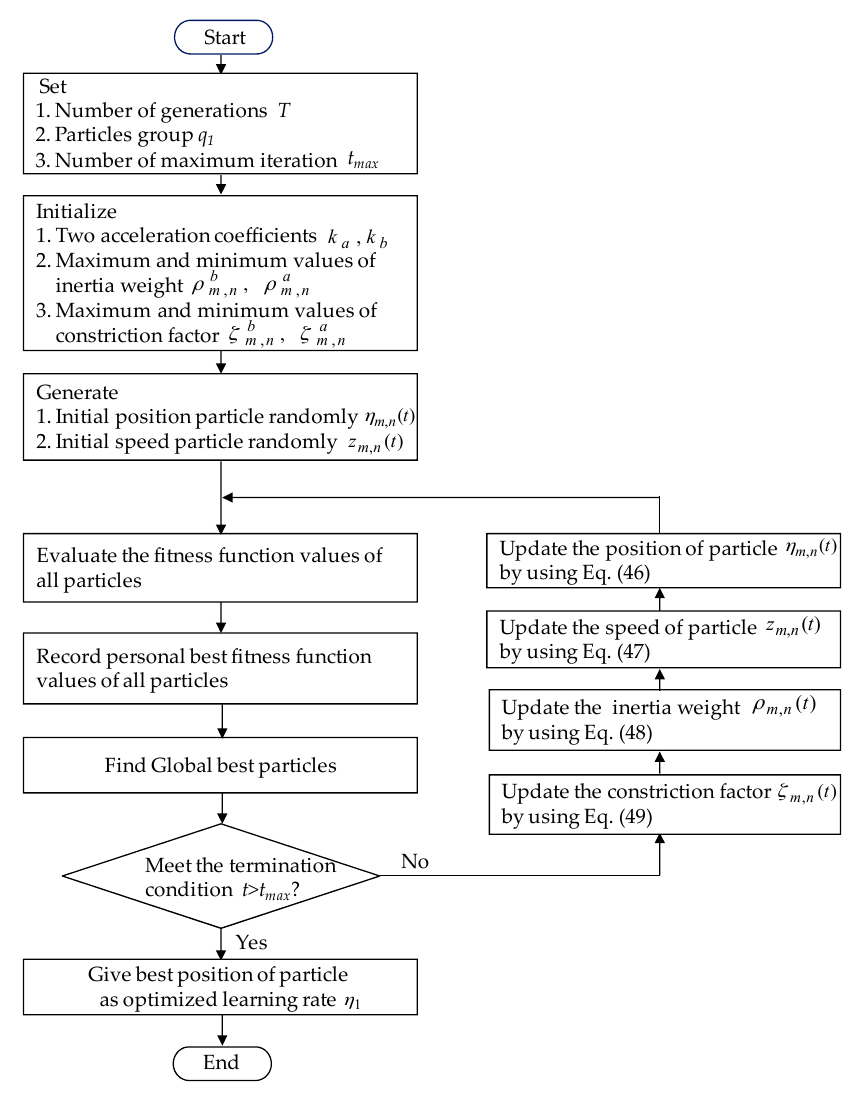
Figure 6. The flowchart result of an optimized learning rate using the mended PSO algorithm.